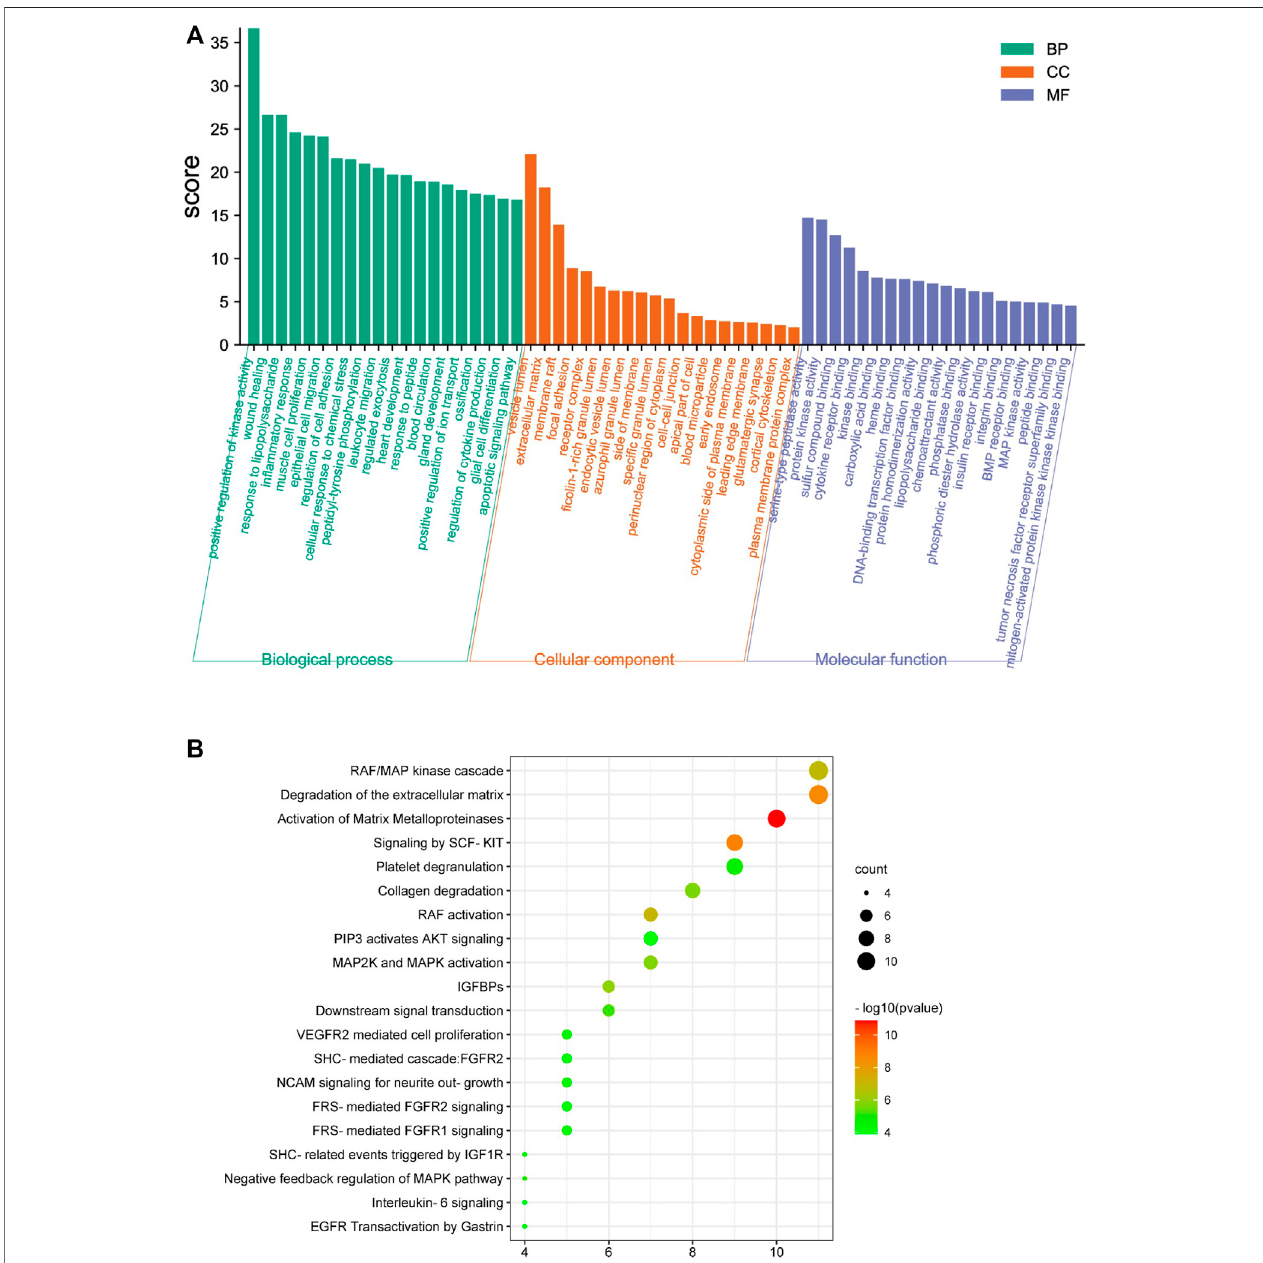
FIGURE3| EnrichmentanalysisofthepotentialtargetsofWBTformulaagainstPFwasperformedbytheMetascapeandDAVIDdatabase. (A) Thetop20termsof biological process (BP), cellular component (CC), and molecular function (MF) of WBT formula are shown as a bar diagram. (B) The top 20 Reactome pathway terms participating in PF are shown as a bubble diagram by the DAVID database, according to the p -value of the calculation.